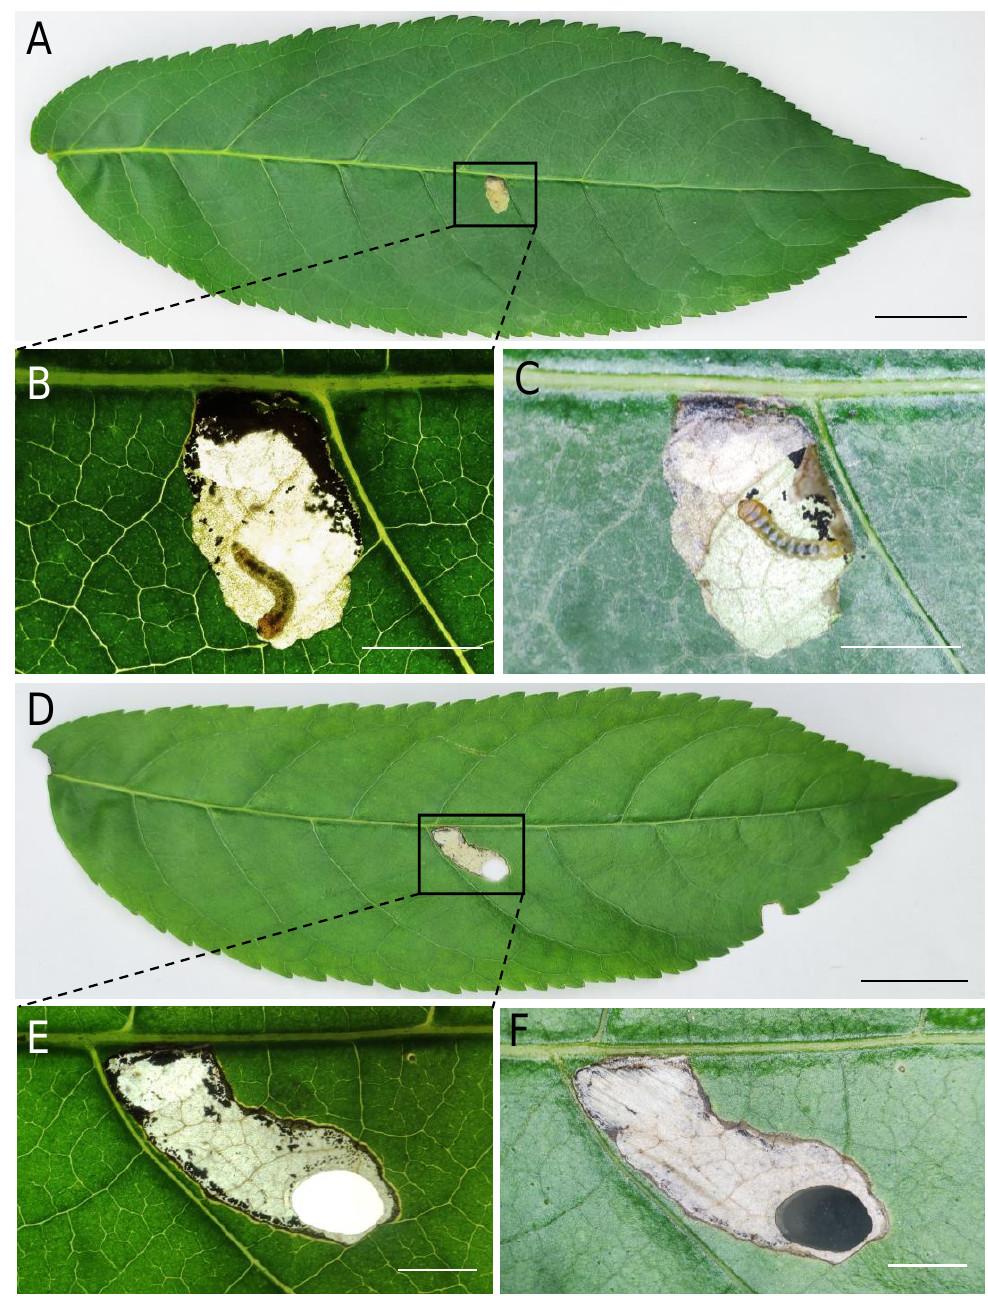
Figure 7. The mines of Coptodisca lucifluella on Pterocarya fraxinifolia found in the Volčji Potok Arboretum, Slovenia, 5–6 August 2022 . ( A – C ) a mine with a live larva in it; ( D – F ) an abandoned mine with a semicircle cut made by larvae when leaving the mine; ( B , E ) in translucent and ( C , D ) in reflected light; ( B , E ) frass is accumulated along the mine margins. Scale: ( A , D ) 10 mm; ( B , C , E , F ) 2 mm. Photo: N.I. Kirichenko, S. Gomboc.